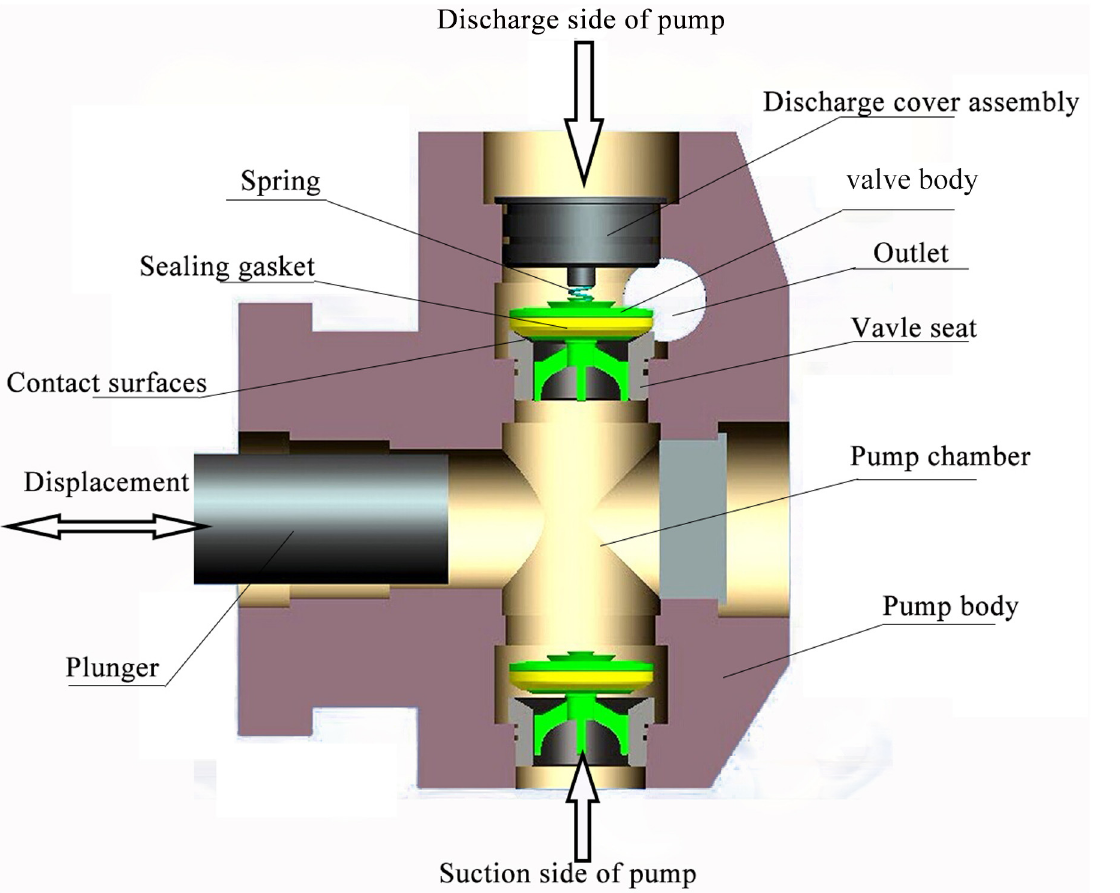
Fig 1. Schematic diagram of fluid end of a reciprocating